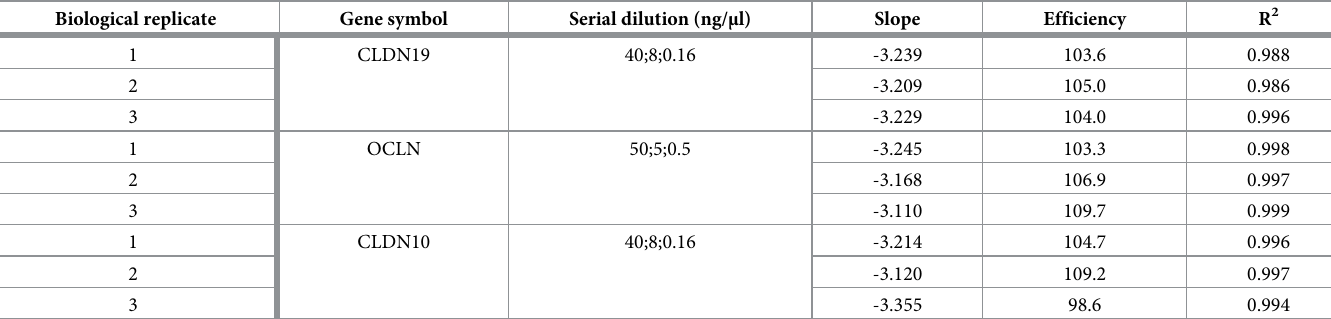
Table 2. Singleplex standardization for jejunum samples.